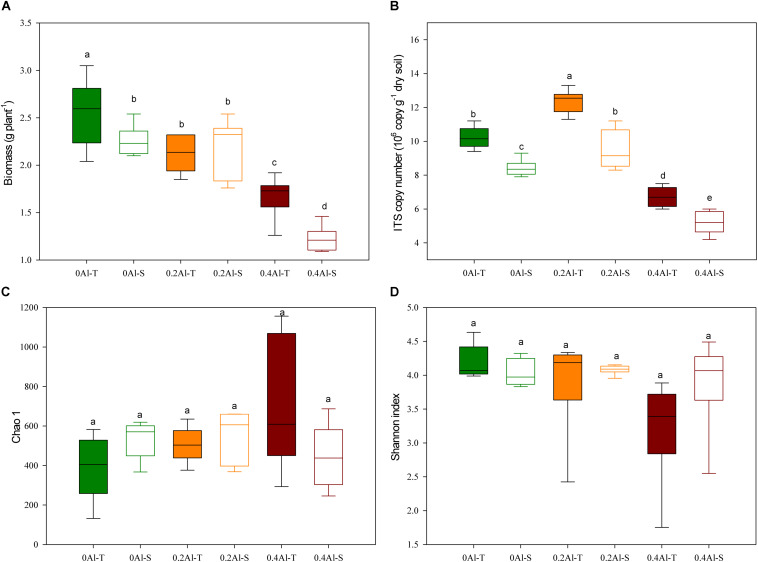
Effects of Al addition (0 g kg–1, 0.2 g kg–1 and 0.4 g kg–1 Al3+) on soybean biomass (A), abundance of soybean rhizosphere fungal ribosomal ITS1 copies (B), soybean rhizosphere soil fungal Chao1 estimated richness (C) and fungal Shannon diversity index (D). One-way ANOVA with Student’s t-test showed significant differences between the Al-T and Al-S (P < 0.05). Error bars on data points represent the standard error of the mean (n = 6). Al-T: Al-tolerant soybean genotypes; Al-S: Al-sensitive soybean genotypes.